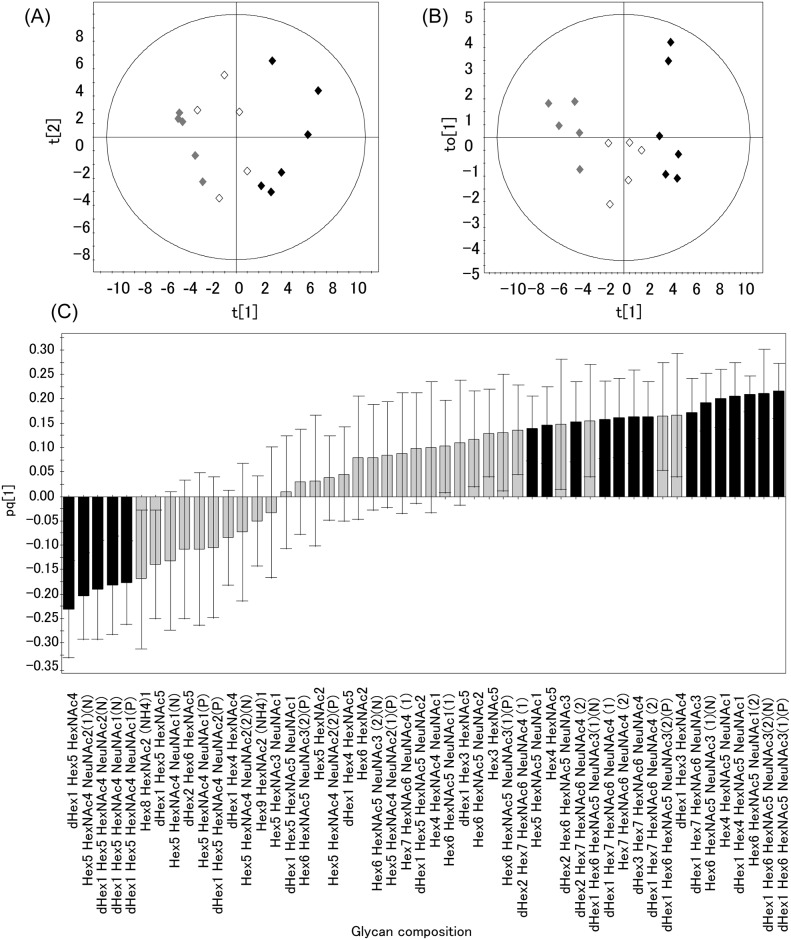
Score plot and loading plot obtained by PCA or O-PLS.(A) A PCA score plot of young controls (shadowed), aged controls (opened), and SSCs (closed) (R2X[1] = 0.329635; R2X[2] = 0.201184; Ellipse: Hotelling T2 (95%)) using the peak area ratios of each N-glycan to the total peak area of all identified N-glycans. (B) An O-PLS score plot between young controls (shadowed), aged controls (opened), and SSCs (closed). R2X [1] = 0.295051, R2X [XSide Comp. 1] = 0.106066, Ellipse: Hotelling T2 (95%) (C) A loading plot with jack-knifed confidence intervals by O-PLS. The pq[1] value is the weight that combines the X and Y variables. The error bar indicates the standard error (SE) of pq[1] values obtained from 16 samples independently. Glycan compositions were deduced by the accurate mass. Numbers in parentheses indicate isomers. “N” or “P” in parentheses indicates the data obtained from the negative or positive ion mode, respectively. Closed and shadowed columns represent [pq1] / SE > 1.5 and < 1.5, respectively. Row data were summarized in S2 Table. Hex, hexose; HexNAc, N-acetylhexosamine; NeuNAc, N-acetylneuraminic acid; dHex, deoxyhexose; NH4, ammonium.